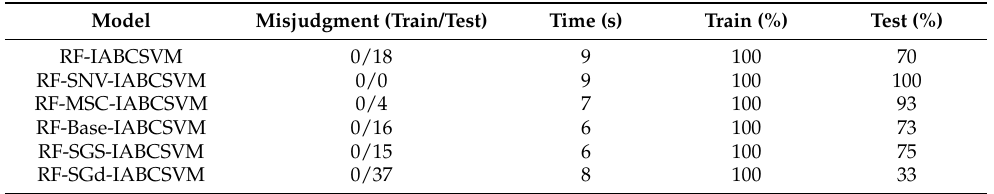
Table 7. The Ranman spectra after five different pretreatments are extracted using the random forest algorithm, and the IABC-SVM classification models are established using the extracted feature variables.